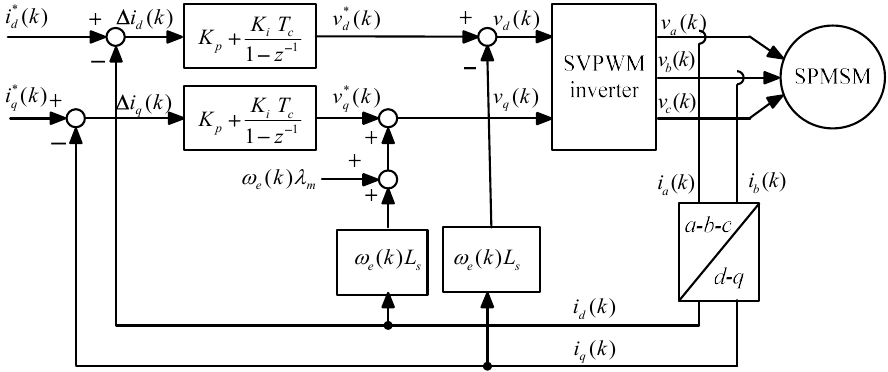
Figure 8. Current-loop PI controller.